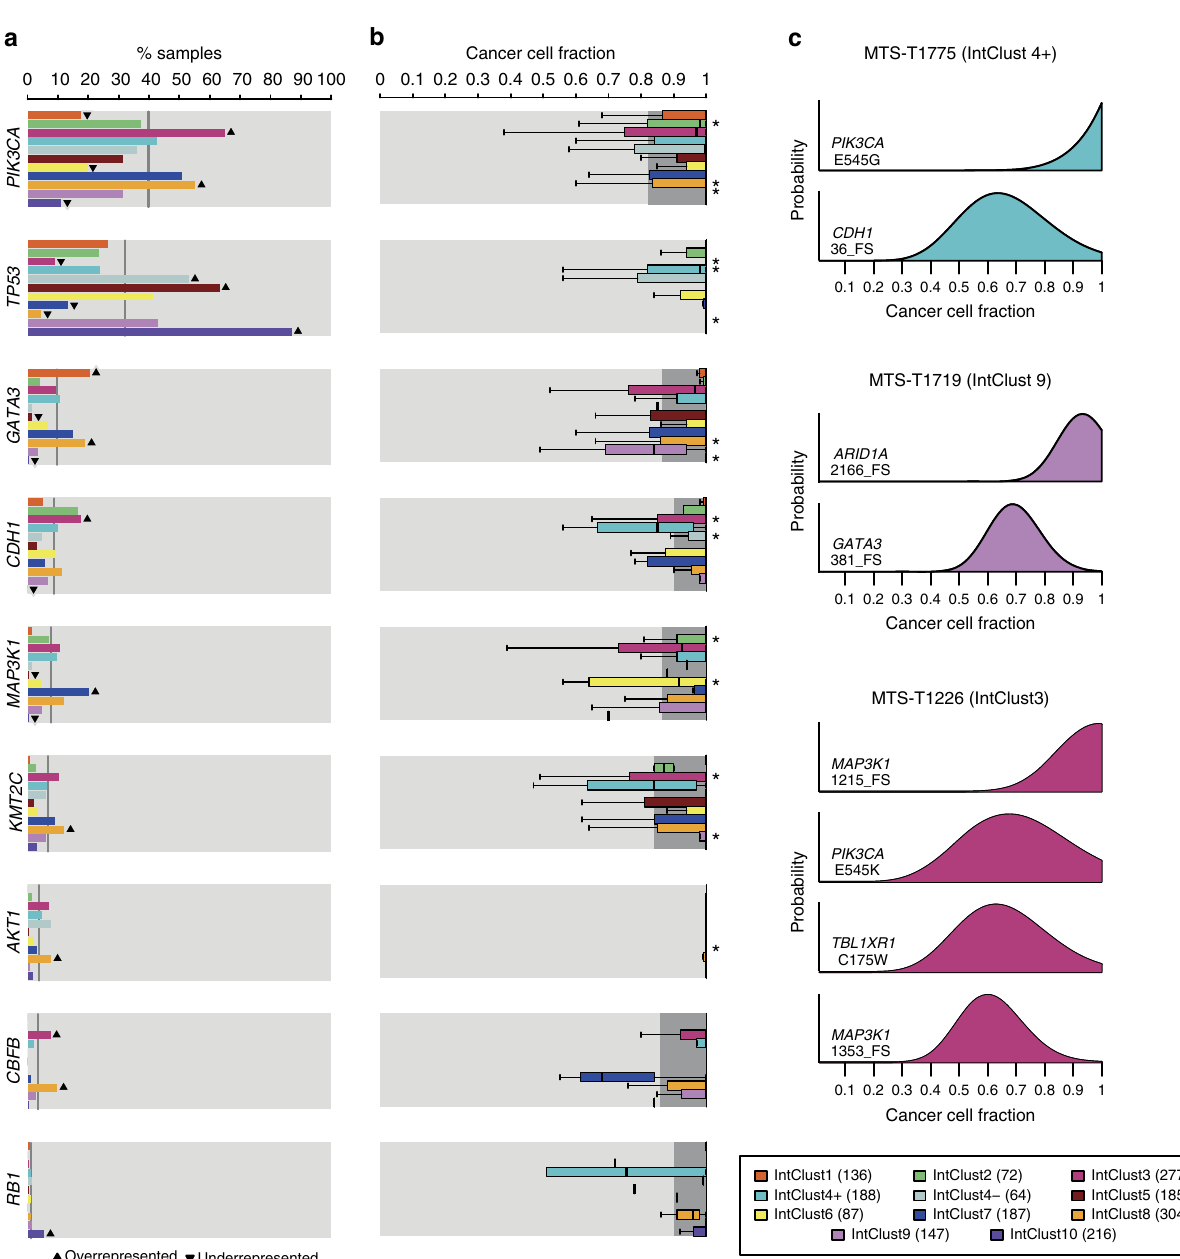
Figure 5 | Prevalence and clonal states of Mut-driver mutations across the Integrative Clusters. ( a ) Bars showing prevalence of mutations for the nine Mut-driver genes that were either under- or over-represented in one of the IntClusts relative to all other samples (Fisher’s exact test; FDR ¼ 0.05). Up arrows and down arrows indicate over/under-representation of mutations, respectively, in the specified IntClust. The grey lines represent mutation prevalence of the indicated gene for all samples in the cohort. ( b ) Box plots depicting cancer cell fractions (CCFs) of mutations in the nine genes across the IntClusts. CCFs were estimated as described in Methods, and we compared the CCF distribution of a gene’s mutations in each IntClust with that of all other tumours. The dark grey shading represents interquartile ranges and outliers are not shown for the purpose of clarity. ‘*’ indicates a significantly different CCF distribution (two-sample Wilcoxon test, P ¼ 0.05). ( c ) Example plots of CCF distributions in individual samples. Three samples (MTS-T1775, MTS-T1719 and MTS-T1226) were considered, and the IntClust to which they belong are also indicated. FS, frameshift